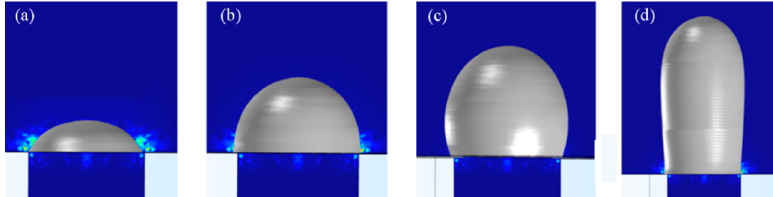
Figure 4. Simulated geometric profile of the polymer pattern formed by extrusion molding process with different operating condition. ( a ) Gibbous shape pattern; ( b ) Domed shape pattern; ( c ) Spherical shape pattern; ( d ) Cylindrical dome pattern.